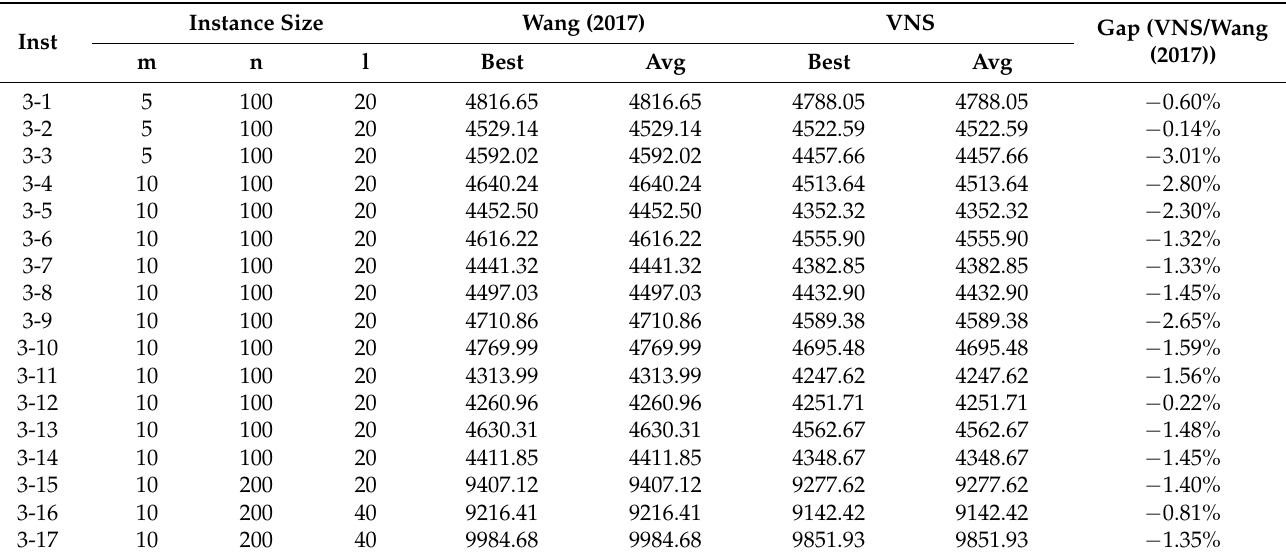
Table 5. Results for the large-sized